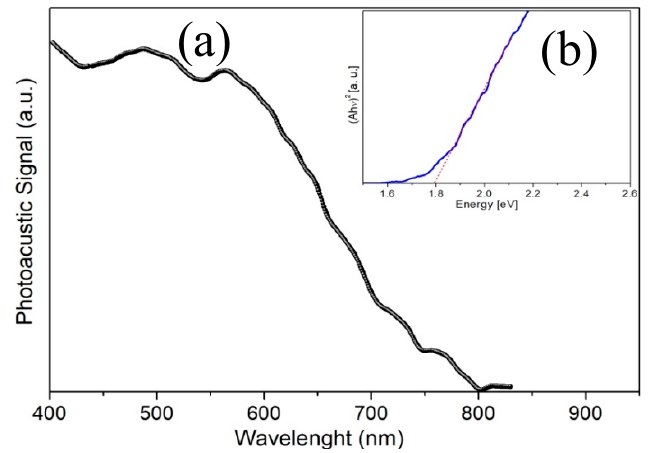
Figure 9. ( a ) PA spectrum as a function of the incident energy’s wavelength, ( b ) optical energy band gap for the MnSb 2 O 6 calcined at 800 °C.